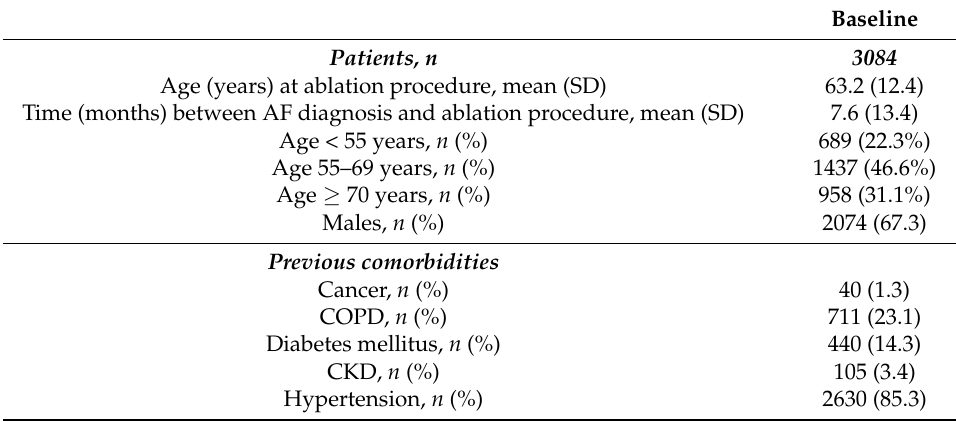
Table 1. Baseline characteristics of AF patients undergoing catheter ablation.